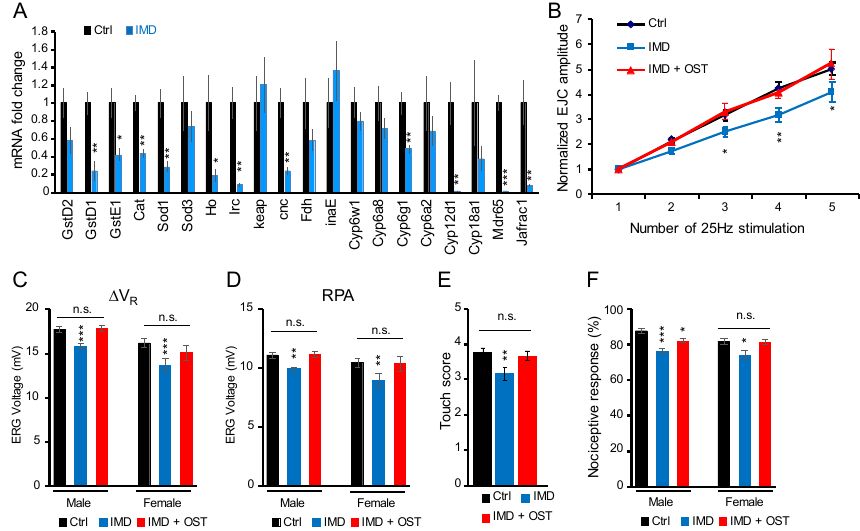
Figure 4. The antioxidant osthole (OST) rescued the phenotypes of the IMD-treated fruit fly: ( A ) differentially expressed genes of the oxidative stress response pathway; ( B ) the rescued 25 Hz short-term facilitation (STF) of the neuromuscular junction; ( C ) the rescued retinal ∆ V R and ( D ) RPA; ( E ) the rescued mechanosensory perception; ( F ) the rescued nociceptive perception. Error bar stands